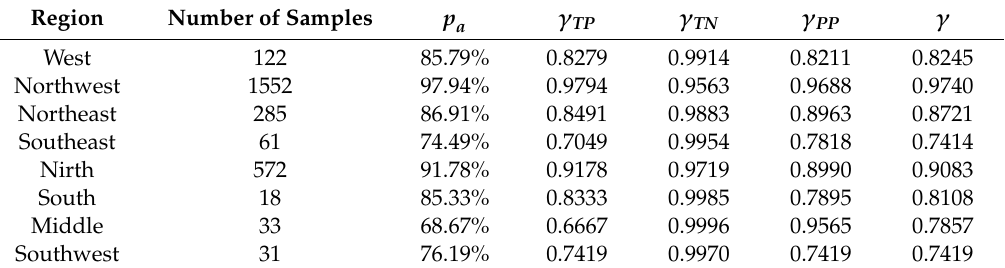
Table 4. Identification capacity of CNN for testing set on terms of five evaluation parameters. ( p a